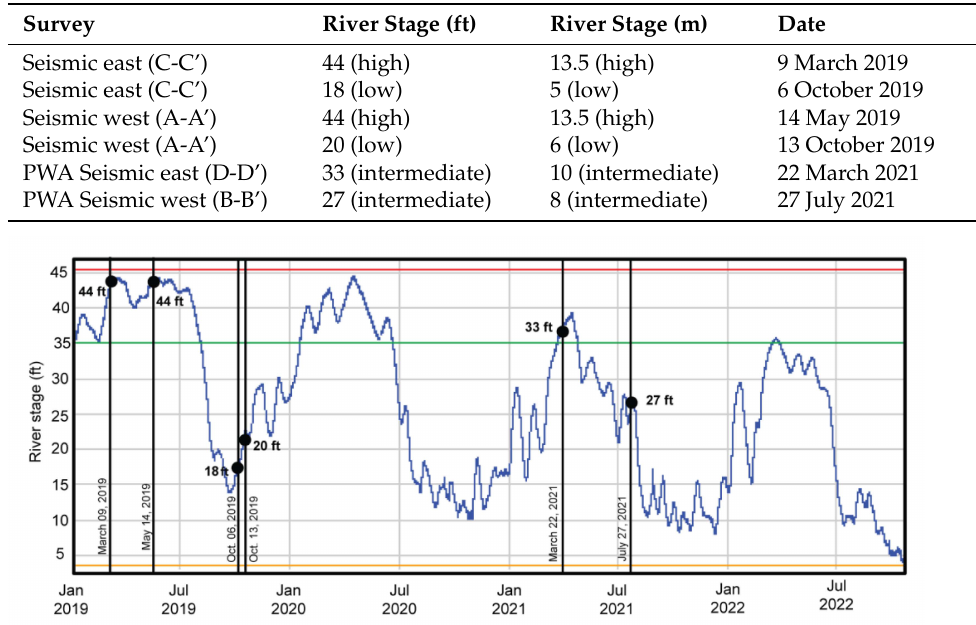
Figure 4. River water stages from January 2019 to November 2022. Monitoring location USGS 07374000 Mississippi River at Baton Rouge, LA. Black circles indicate seismic acquisition dates with their respective river stages in the Vet. School grounds. The blue curve is the river stage, the red line is the maximum recorded river stage, the yellow line is the lowest recorded river stage, and the green line is the national weather service flood